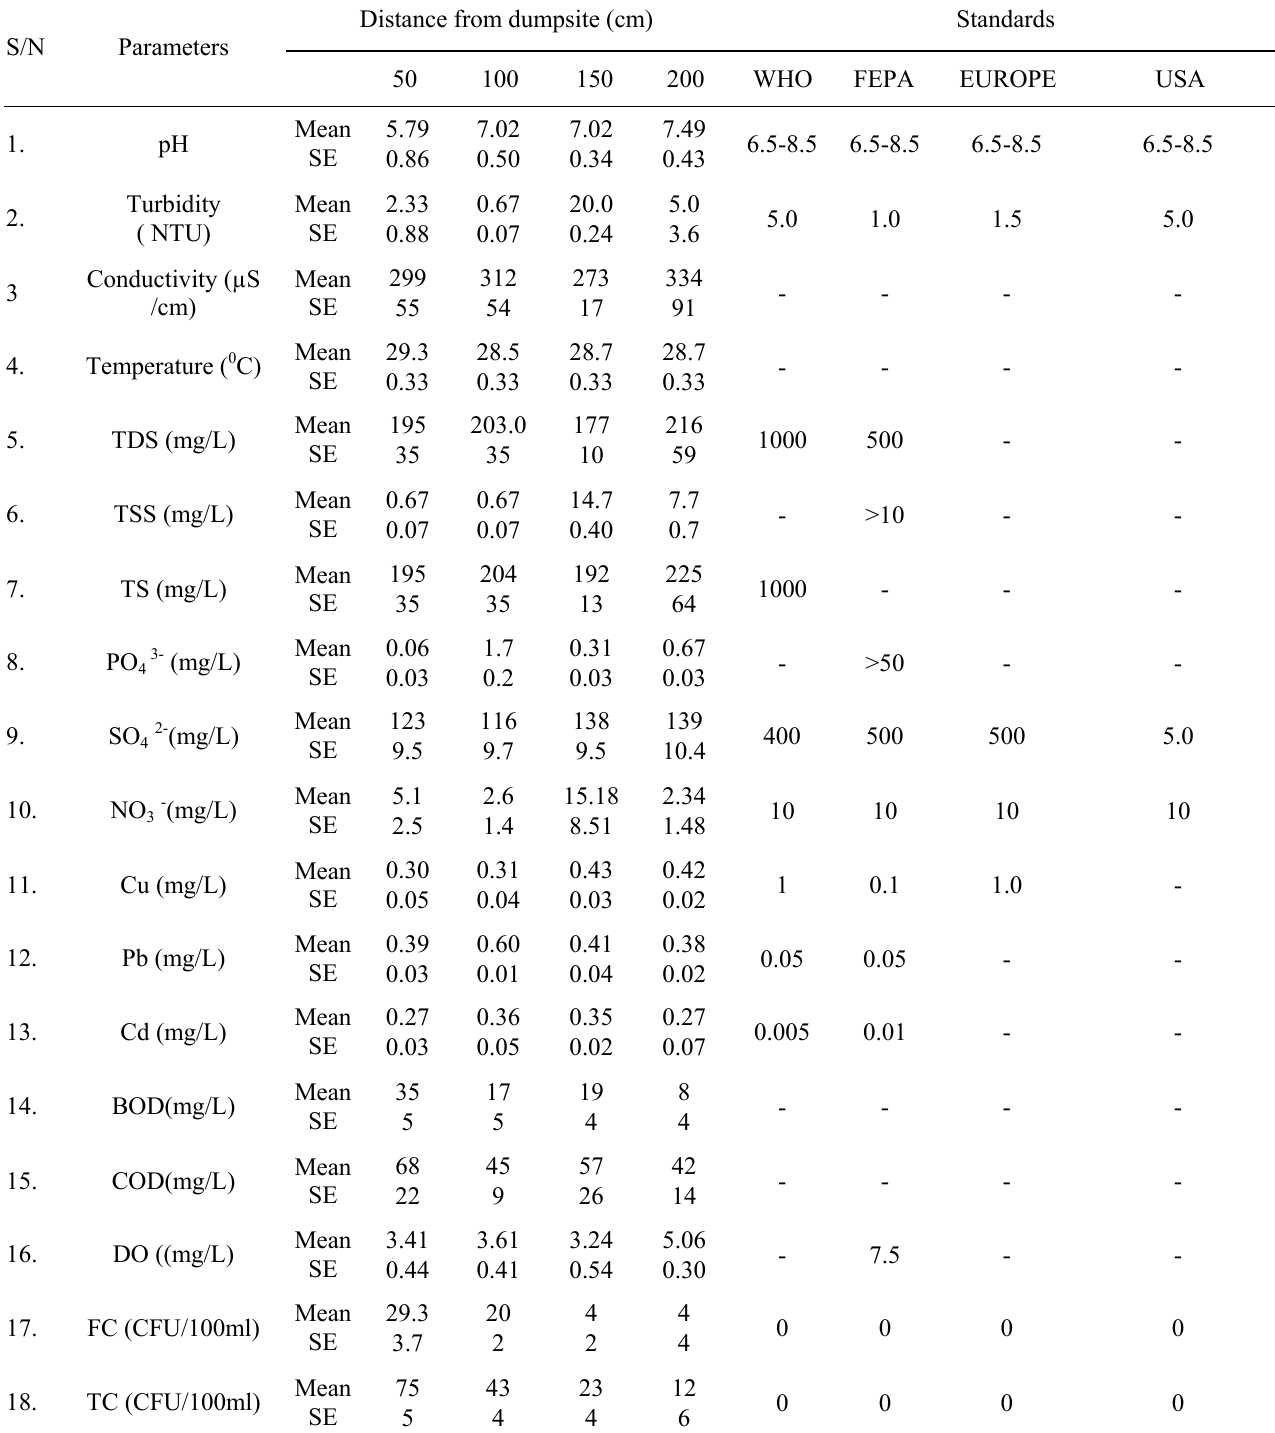
Table 4 : Mean values of the water quality parameters of wells located close to close to defecation site in the wet season